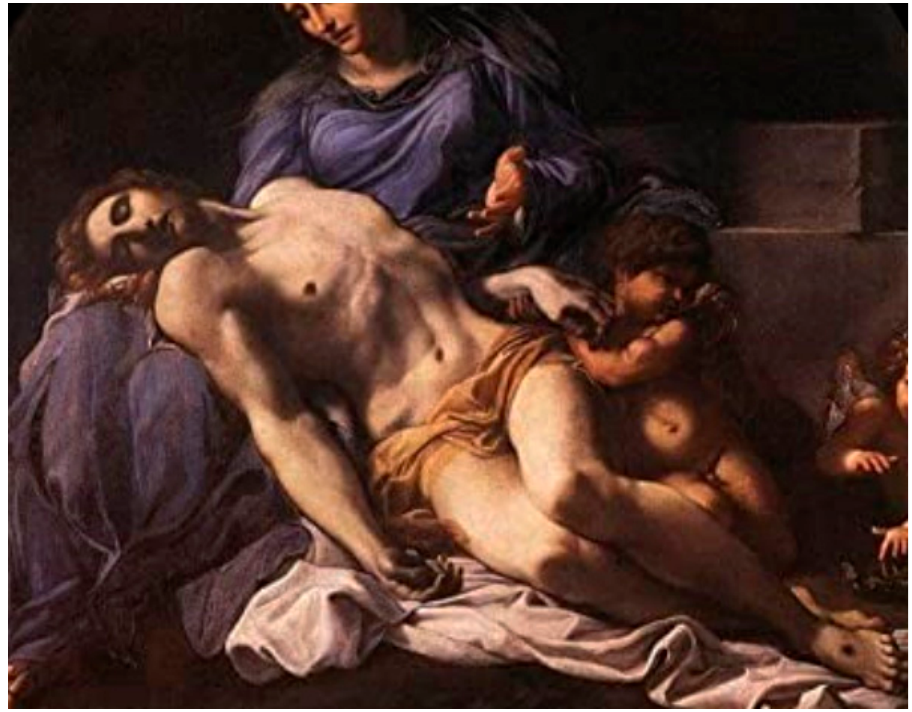
Figure 10. Annibale Carracci’s Pietá. A close-up view of a section. Michelangelo was educated and trained in Florence, under the protection of the Medici’s family. An open-minded cultural climate prevailed because invited guests and denizens from different religious traditions and schools spent some time teaching and copying and bringing into existence in the